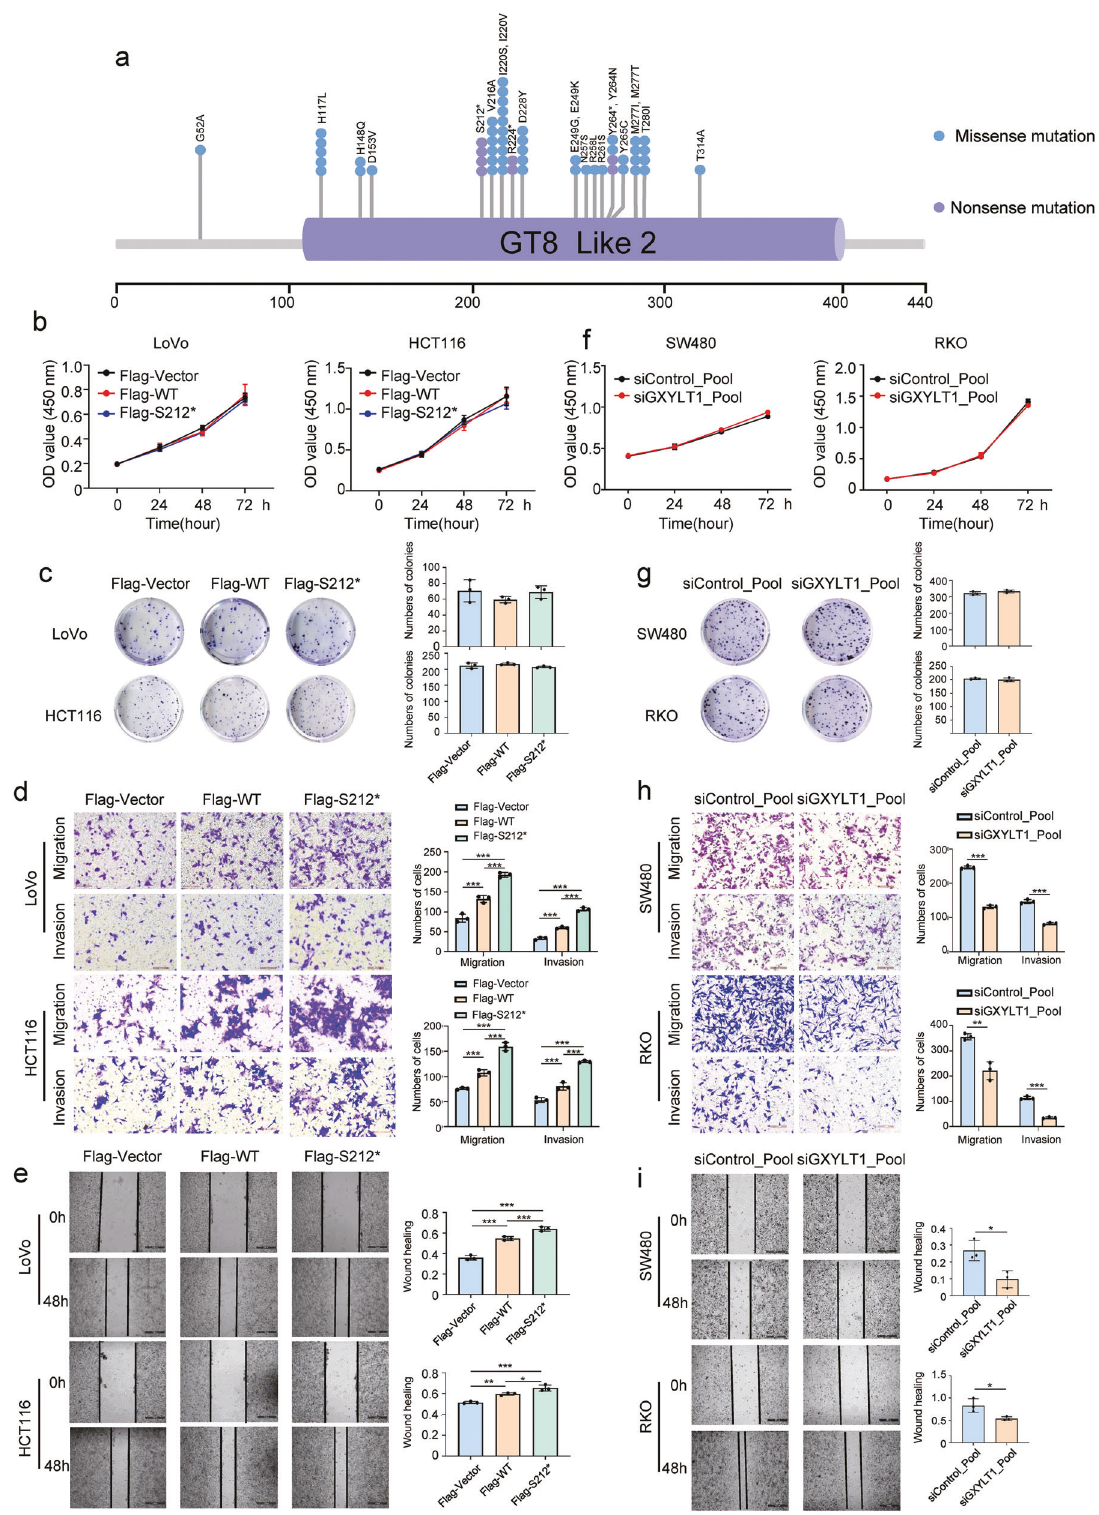
Fig. 3 GXYLT1 promotes CRC cell migration and invasion, while GXYLT1 S212* exerts a stronger effect in vitro. a Somatic mutations in the GXYLT1 functional domain. Numbers represent amino acid residues. Each dot represents an individual mutated tumor sample. Blue dot: missense mutation. Purple dot: nonsense mutation. b , f Cell viability was assessed using CCK-8 assays in CRC cells transfected as indicated. c , g Representative images of colony formation in CRC cells transfected as indicated. Graphs show the numbers of colonies. d , h Transwell migration and invasion assays in CRC cells transfected as indicated. Graphs show quanti fi cation of migrated cells. e , i Wound-healing assays to evaluate cell migration in CRC cells transfected as indicated. Graphs show quanti fi cation of the wound-healing area. Data are presented as the mean ± SD of at least three independent experiments. * p < 0.05, ** p < 0.01, *** p < 0.001. Cell Death and Disease (2022)